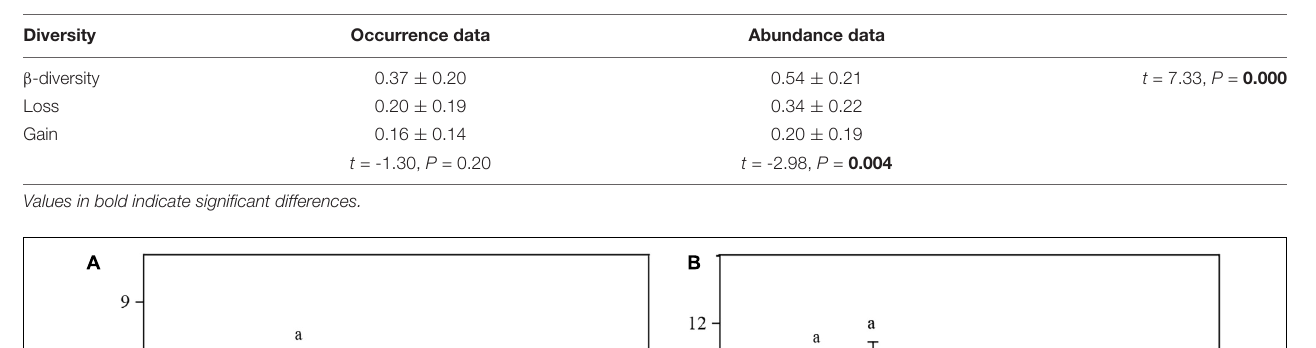
TABLE 3 | Variation in beta diversity ( β -diversity) between the data types and the difference between losses and gains components for each data type based on paired samples t